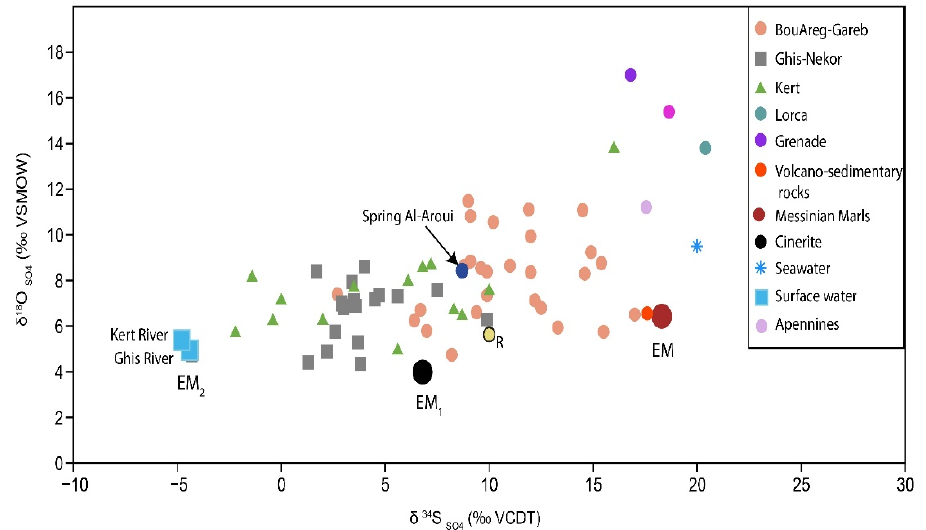
Figure 7. Cross-plot of δ 34 S versus δ 18 O SO4 of groundwater, Messinian marls, cinerite, volcano-sedi- mentary rocks, and Messinian gypsum are from Grenade and Lorca [ 42 ] and Triassic sulfates from Apennines Italy [ 43 ] , EM-Messinian marls, EM 1 -volcanic products, EM 2- surface waters.